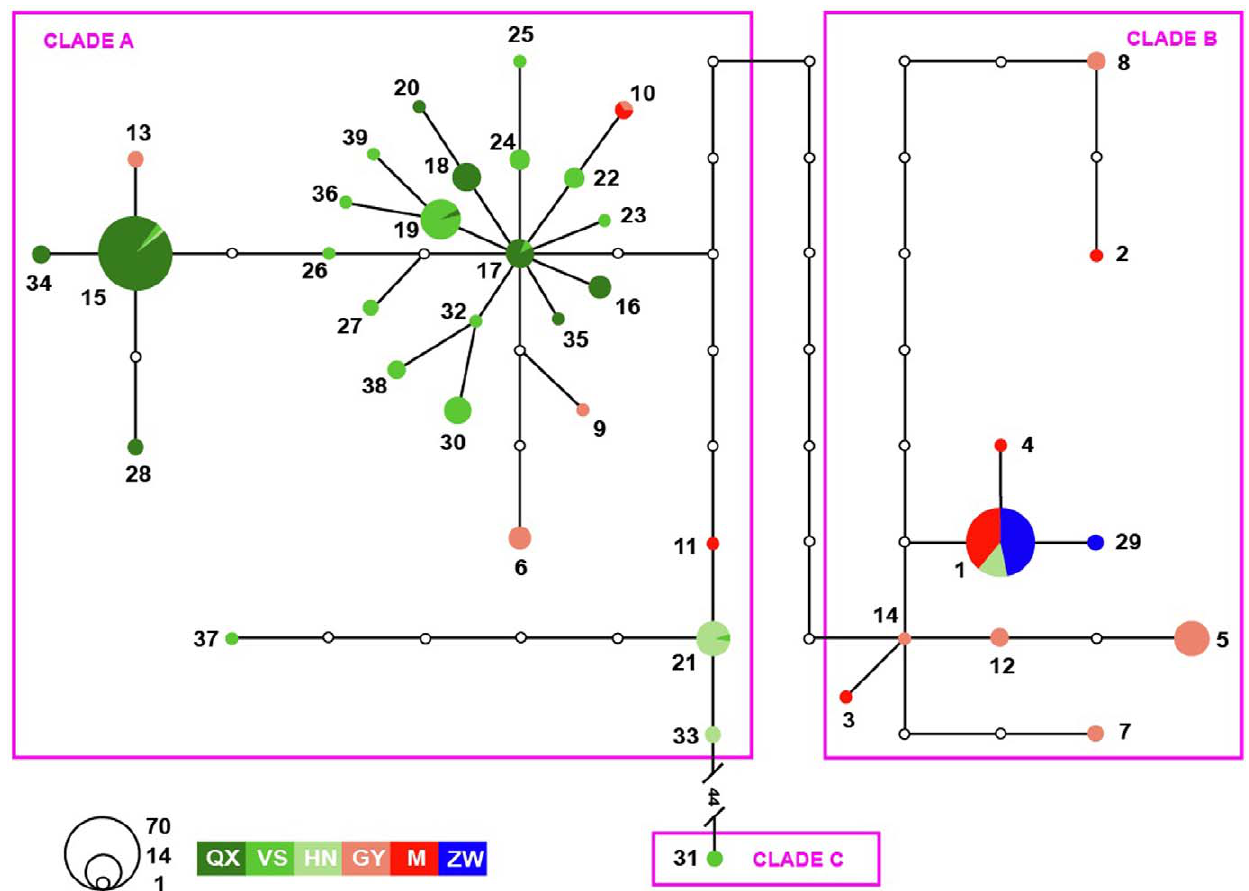
Figure 2. Network of 39 mitochondrial cytochrome b haplotypes from 269 individual Najaatra . The size of the circles is proportional to haplotype frequency; small open circles represent intermediate haplotypes that are not in our study. See Table 1 for sample sites abbreviations. Sites where most individuals were assigned to the same cluster on the basis of microsatellite data have gradations of the same color (s). Table 1. Samples sites, sample size ( N ), number of haplotypes ( h ), haplotype diversity (Hd), nucleotide diversity ( p ), Fu’s Fs , Tajima’s D , sum of square deviation (SSD), Harpending’s raggedness index (HRI), t , number of alleles ( N A ), allelic richness ( AR ), number of private alleles ( N PA ), observed heterozygosity ( H O ) and expected heterozygosity ( H E ) for Naja atra .